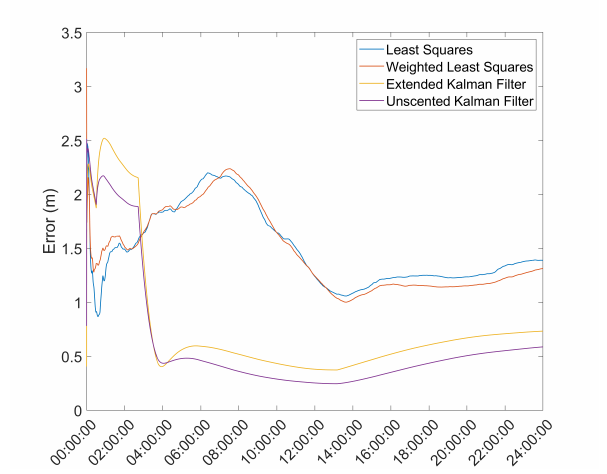
Figure 3. Mean error variation over time for the base station antenna with no Hatch Filter.